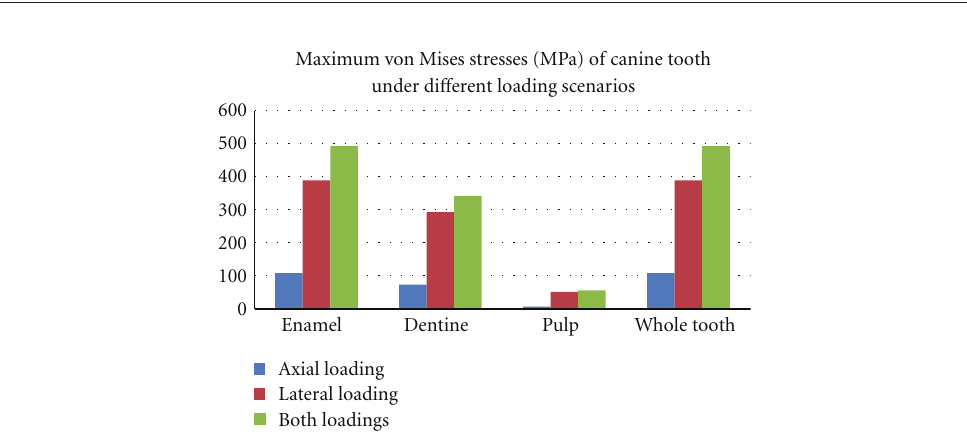
Figure 6: Maximum von Mises stresses (MPa) in tooth tissues under di ff erent loading